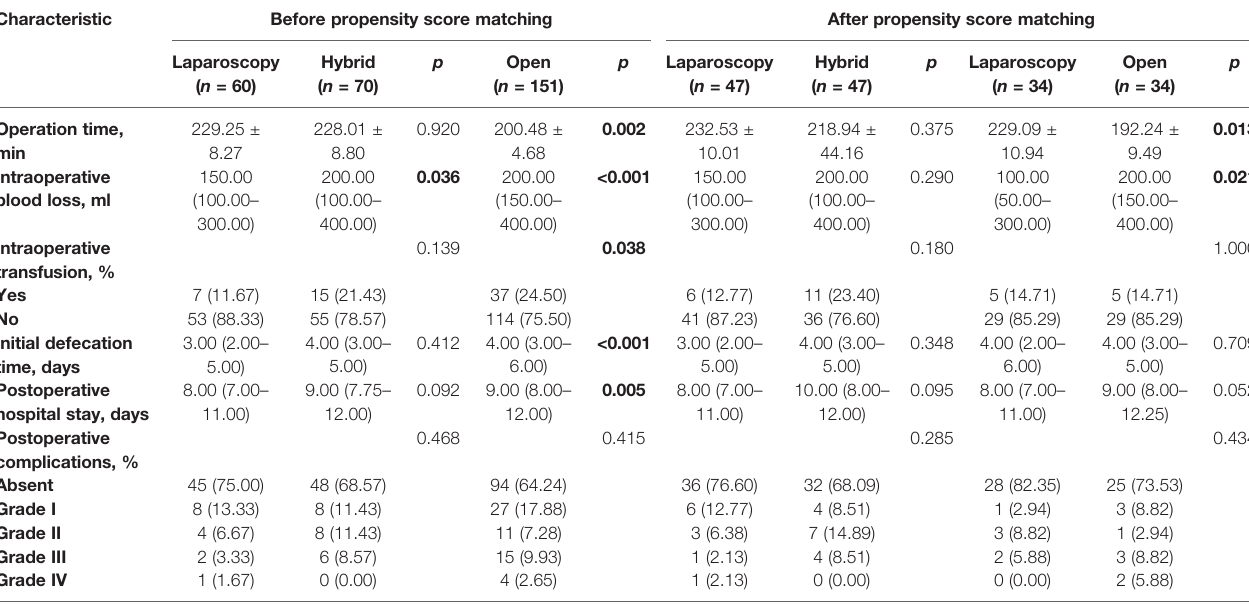
TABLE 2 | Operation-related